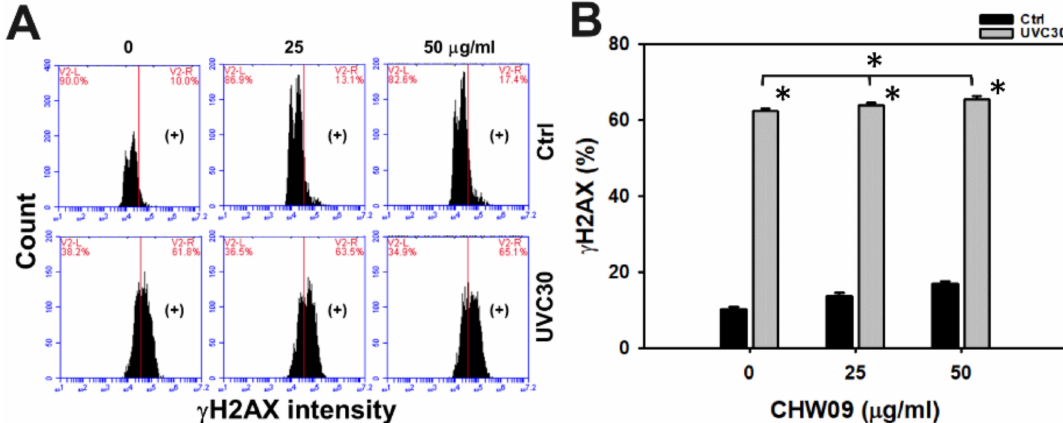
Figure 8. Changes of DNA damage of UVC and / or CHW09 treatments in oral cancer Ca9-22 cells. Cells were pretreated with UVC irradiation (0 and 30 J / m 2 ) and / or post-treated with CHW09 (control, 25, and 50 µ g / mL) for 24 h. ( A ) Representative pattern of γ H2AX analysis for UVC and / or CHW09 treatment. ( + ) in the right side indicates the γ H2AX ( + ) (%). ( B ) Statistics in Figure 8A. Data, mean ± SD ( n = 3 independent experiments). For multiple comparison, significance of the di ff erence was examined by one-way ANOVA and the Tukey HSD Post Hoc Test. *, p < 0.0001. * without line indicates the significance between control and UVC30. * with line indicates the significance between UVC30 / CHW09 and